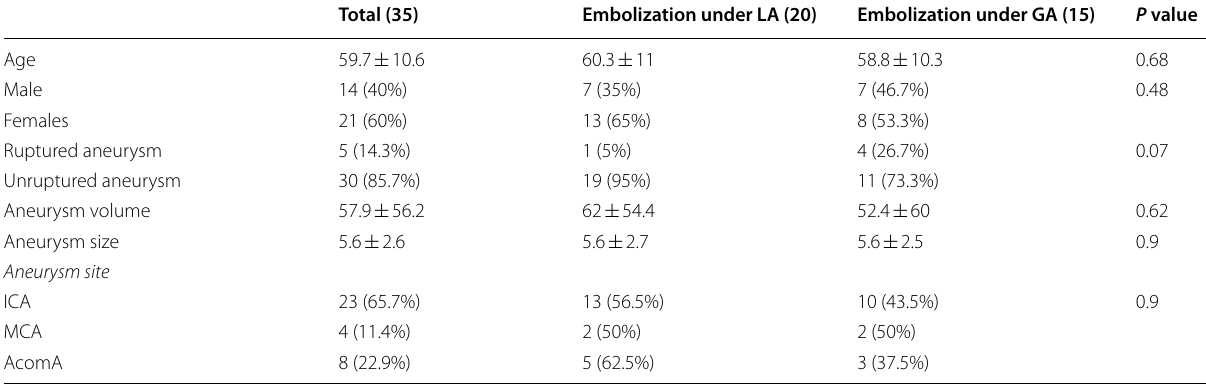
Table 1 Patients and aneurysm